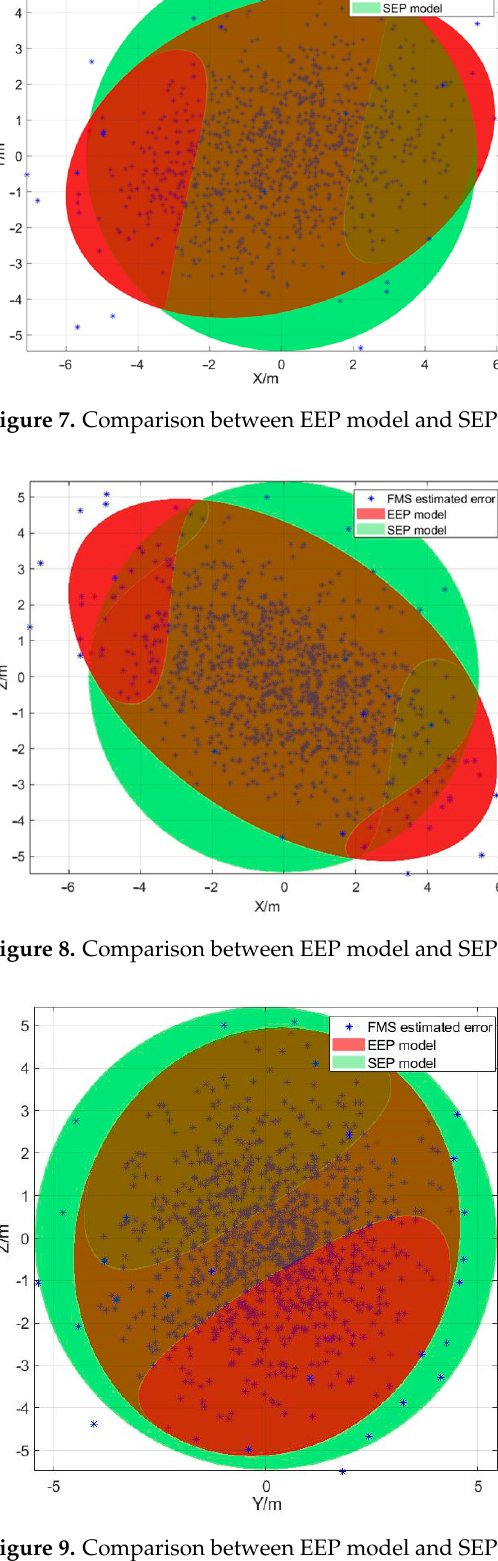
Figure 10. Three-dimensional ANP calculation process. Algorithm 1: Calculation process of three-dimensional ANP evaluation method Step 1 : Get the position error covariance matrix V from the FMS. Step 2 : Similarity transform the position error covariance V to obtain the positive definite covar- iance matrix V m. Step 3 : Use numerical integration iterative to obtain the inclusion probability P of the EEP model. Step 4 : If 0.95 P ξ− <